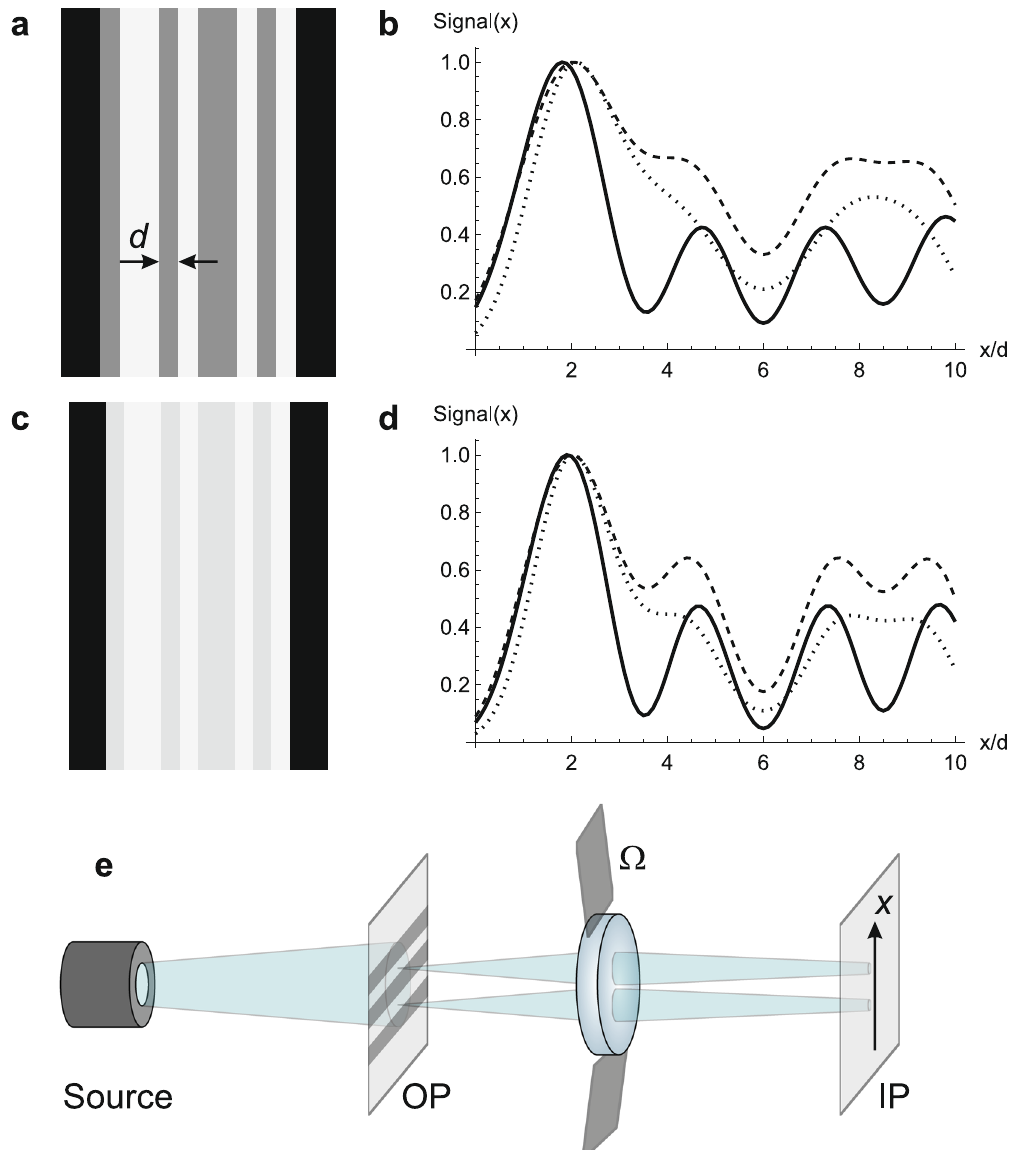
Fig. 3 Application of the resolution-enhancement ideas to a realistic setup. Model objects ( a , c ), imaging scheme for ( n − 1)-photon coincidence conditioned by detecting a photon in the region Ω ( e ), and simulation results ( b , d ). Sets of semitransparent slits with transmission amplitudes 0.5 ÷ 1 ( a ) and 0.9 ÷ 1 ( c ) were used as model objects. The signal ( G ( n ) — dotted lines, G ( n − 1) — dashed lines, G ( n − 1,1) — solid lines) was simulated for the object from panel a , k max d ¼ 1 , and n = 3 ( b ) and 4 ( d ). The detection region for the n th photon is Ω ¼ f k : k max (cid:6) j k j (cid:6) 2 k max g . The axis x is directed across the slits. The coordinate x is normalized by the slit size d indicated in plot a